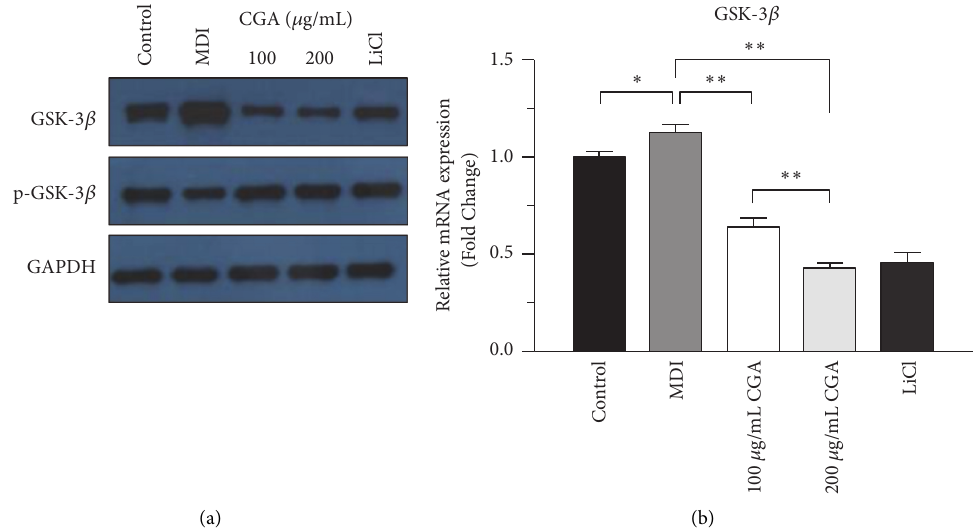
Figure 7: Activation of the Wnt/ β -catenin signaling pathway by chlorogenic acid targeting GSK3 β . (a) The protein expression of phospho- GSK3 β and total GSK3 β by Western blotting. (b) The gene expression of GSK3 β in 3T3-L1 cells. Data are presented as means ± SE from three independent experiments. ∗ P < 0 . 05, ∗∗ P < 0 .